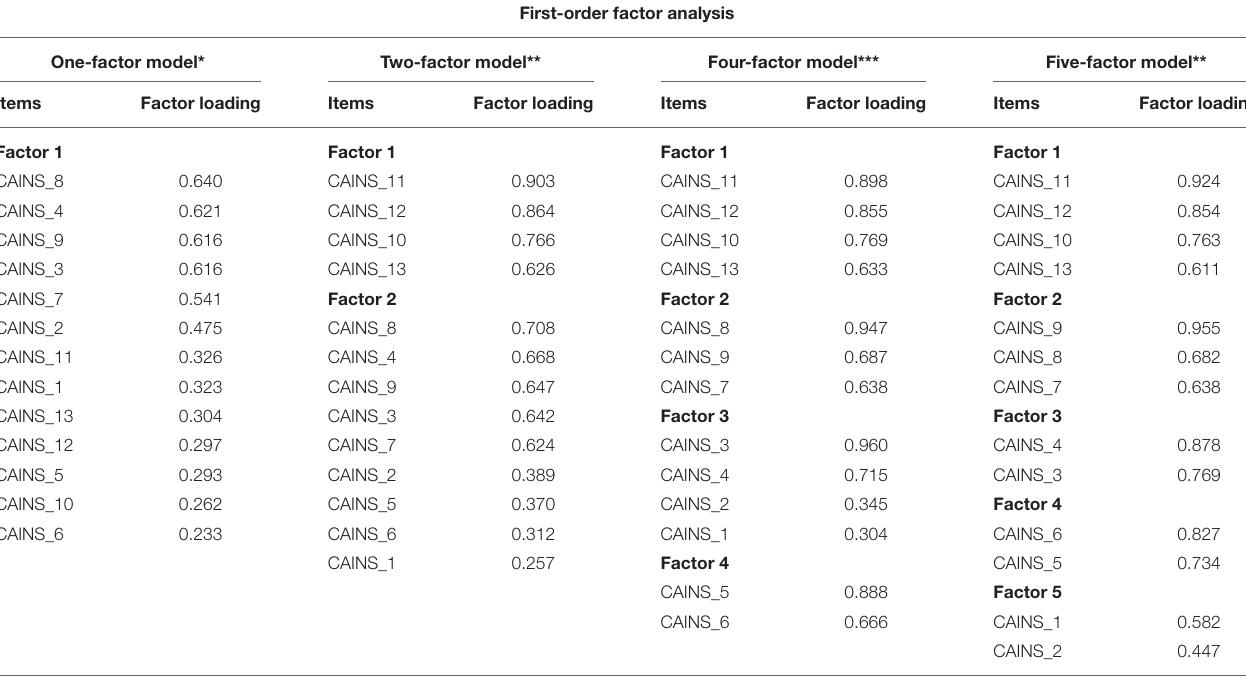
TABLE 2 | One-, two-, and five-factor model derived from exploratory factor analysis.